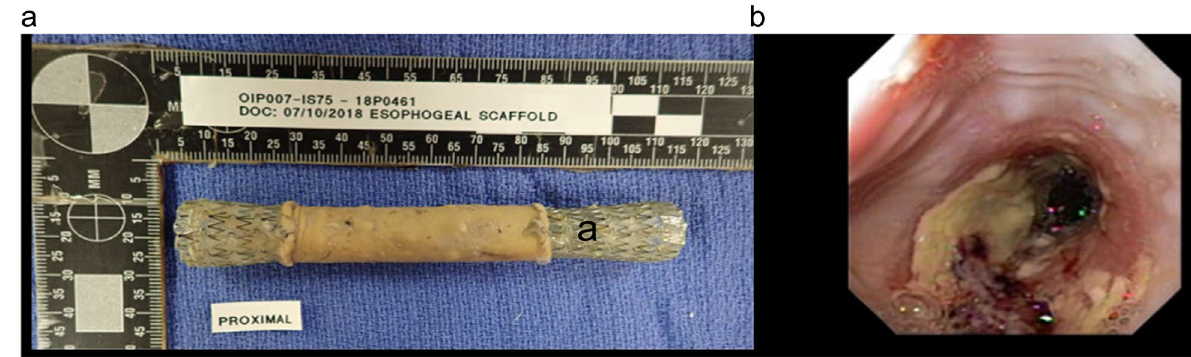
Fig. 1 Retrieval of scaffold and initial stent followed by an esophagram at 21 days post implant. At the time of the fi rst endoscopy (21 days post-surgery), the initial stent with the scaffold attached is removed ( a ). An endoscopic image illustrating the lumen of a patent fi brovascular tube of tissue following scaffold and stent removal ( b ); white arrow indicates regeneration